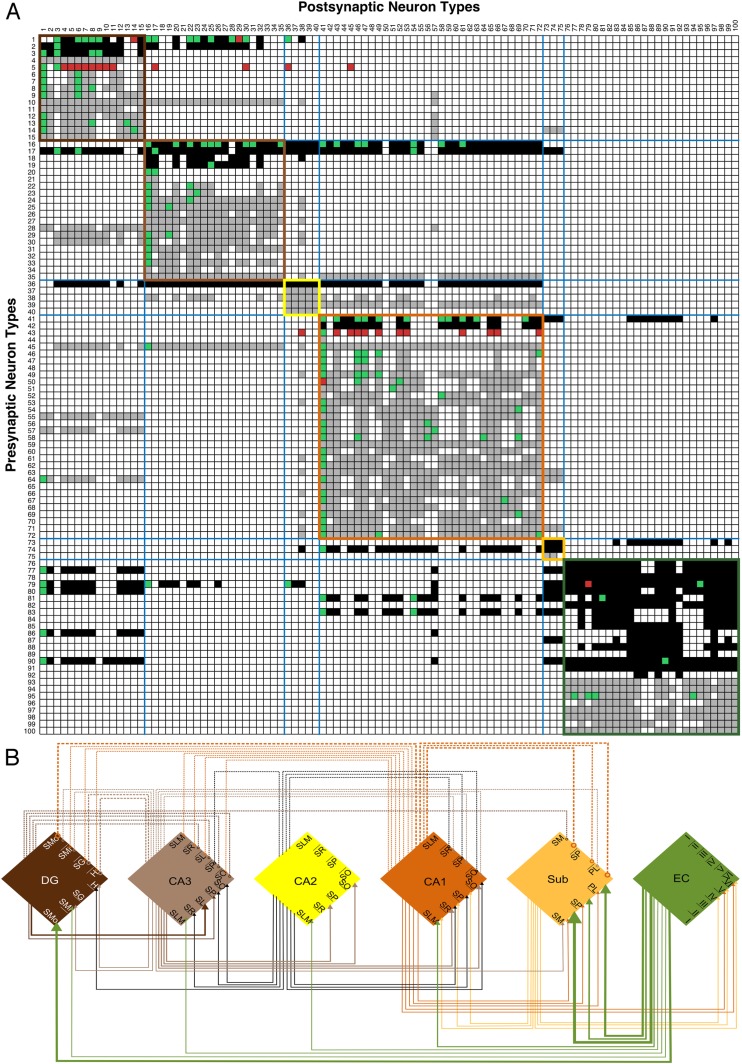
Neuron type connectivity (area color coding and numbering as in Figure 1).(A) Known and potential connections for 100 neuron types (full matrix: hippocampome.org/connectivity or hippocampome.org/php/images/connectivity/Connectivity_Matrix.jpg), with pre-synaptic types in rows and post-synaptic types in columns. Black squares indicate potential glutamatergic connections and gray squares GABAergic. Pairs of neuron types with experimentally established and refuted synapses are shown using green and red squares, respectively. Colored boundaries demarcate intra-area connections. (B) Regional pathways with 33 glutamatergic connections (full lines ending in arrows) and 20 GABAergic connections (dashed lines ending in open circles); line thickness represents the numbers of connected neuron types between areas.